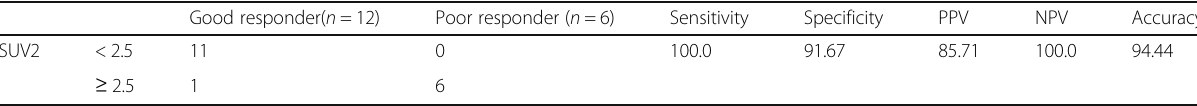
Table 3 Agreement (sensitivity, specificity) for